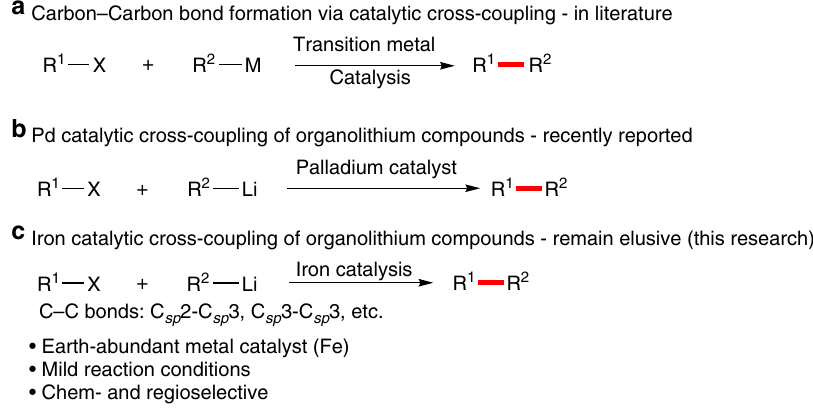
Figure 1 | Transition metal-catalysed cross-coupling to form carbon–carbon bonds. ( a ) C–C bond formation via catalytic cross-coupling. ( b ) Palladium- catalysed cross-coupling of organolithium compounds. ( c ) Iron-catalysed cross-coupling of organolithium reagents. NATURE COMMUNICATIONS|7:10614|DOI: